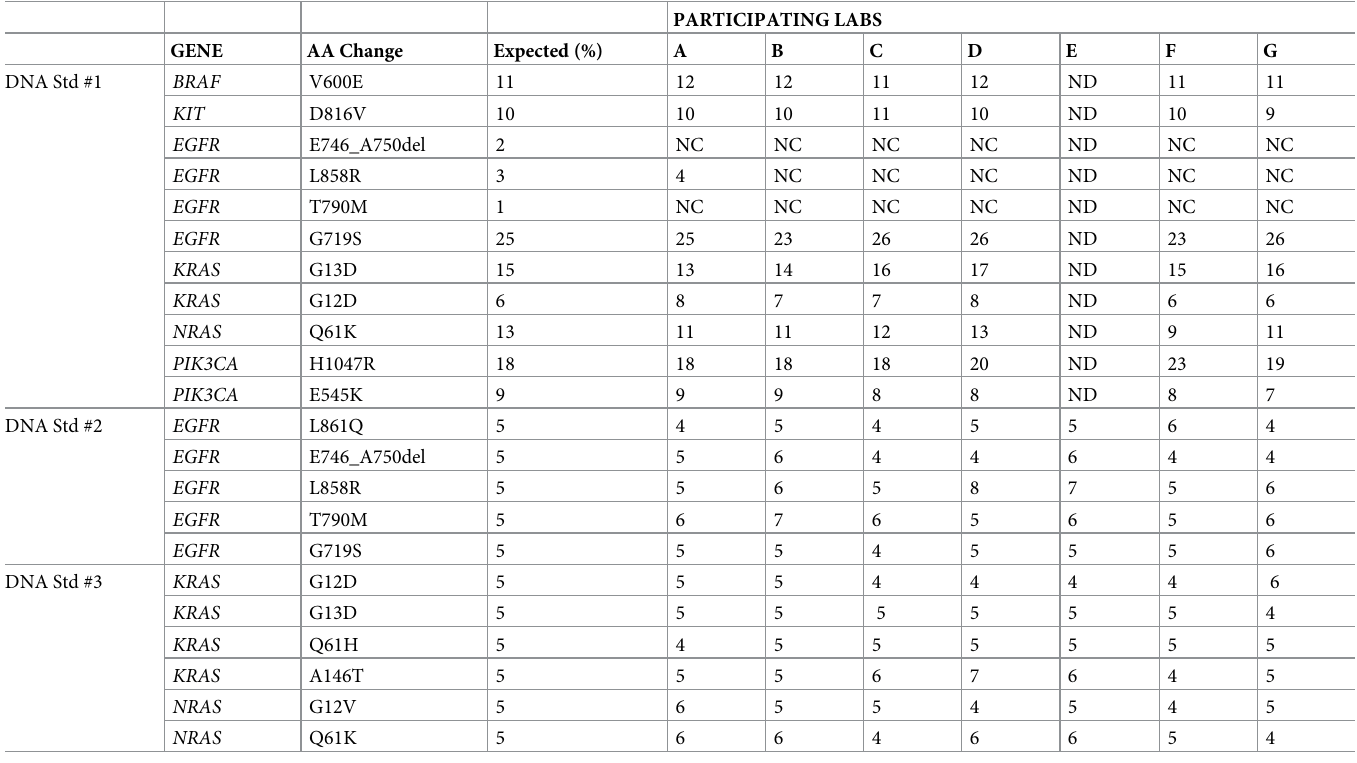
Table 12. Variant allele fractions for DNA control specimens across the ring study laboratories.